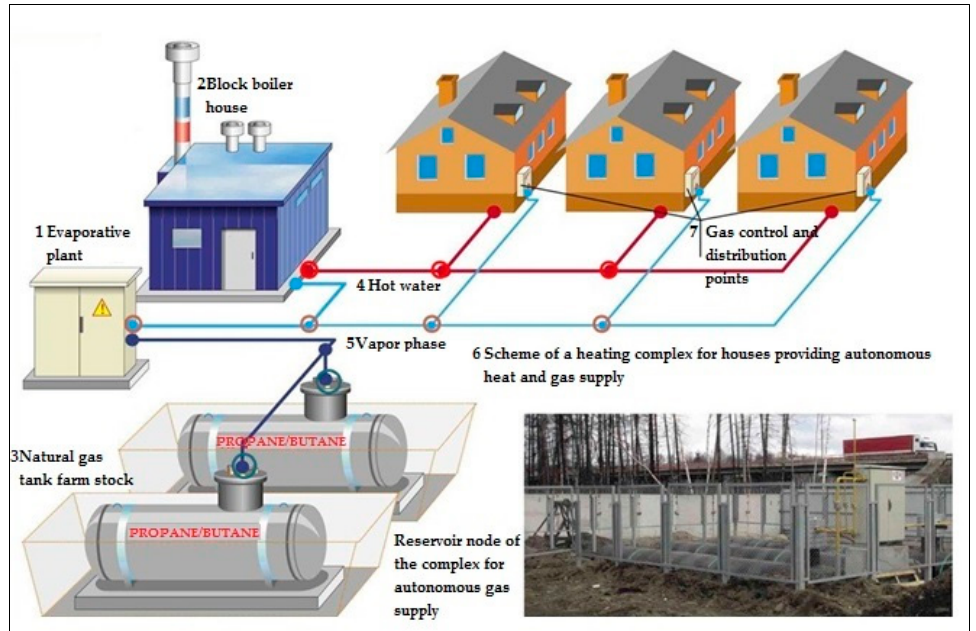
Figure 5. The gas supply scheme for residential buildings.